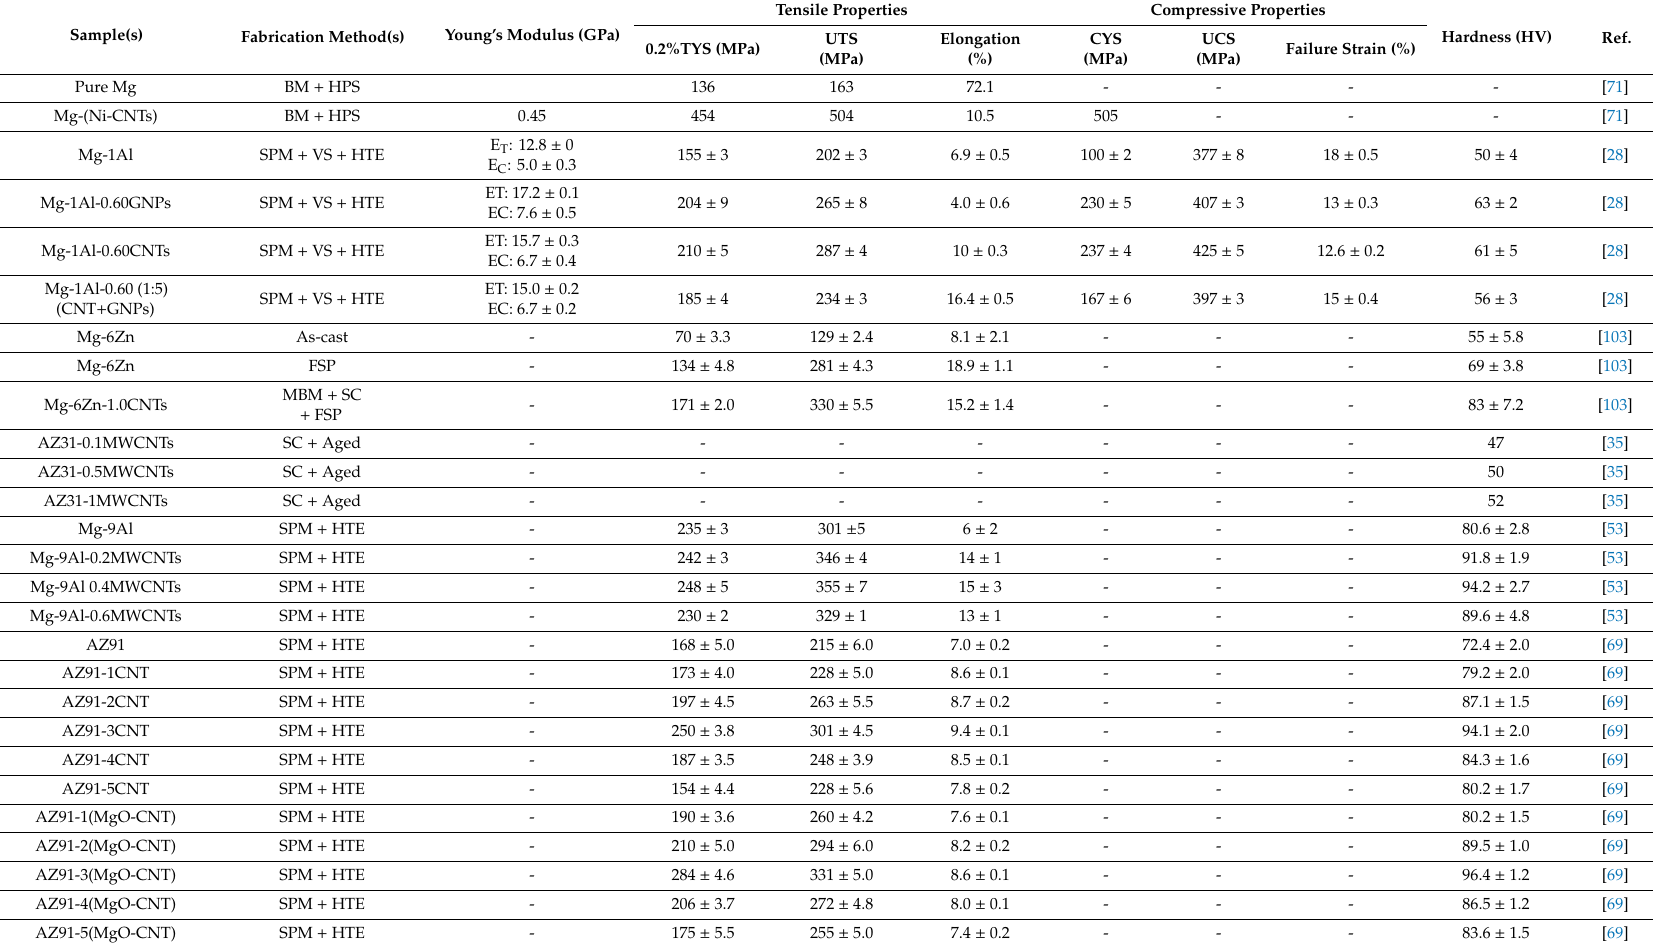
Table 1. Mechanical properties of Mg-CNT